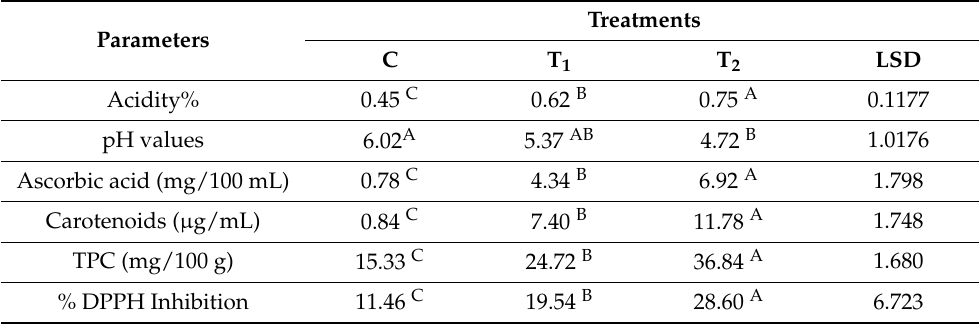
Table 3. Titratable acidity, pH values, total phenolic content, and % DPPH inhibition of a yogurt drink fortified with golden berry juice on the first day of